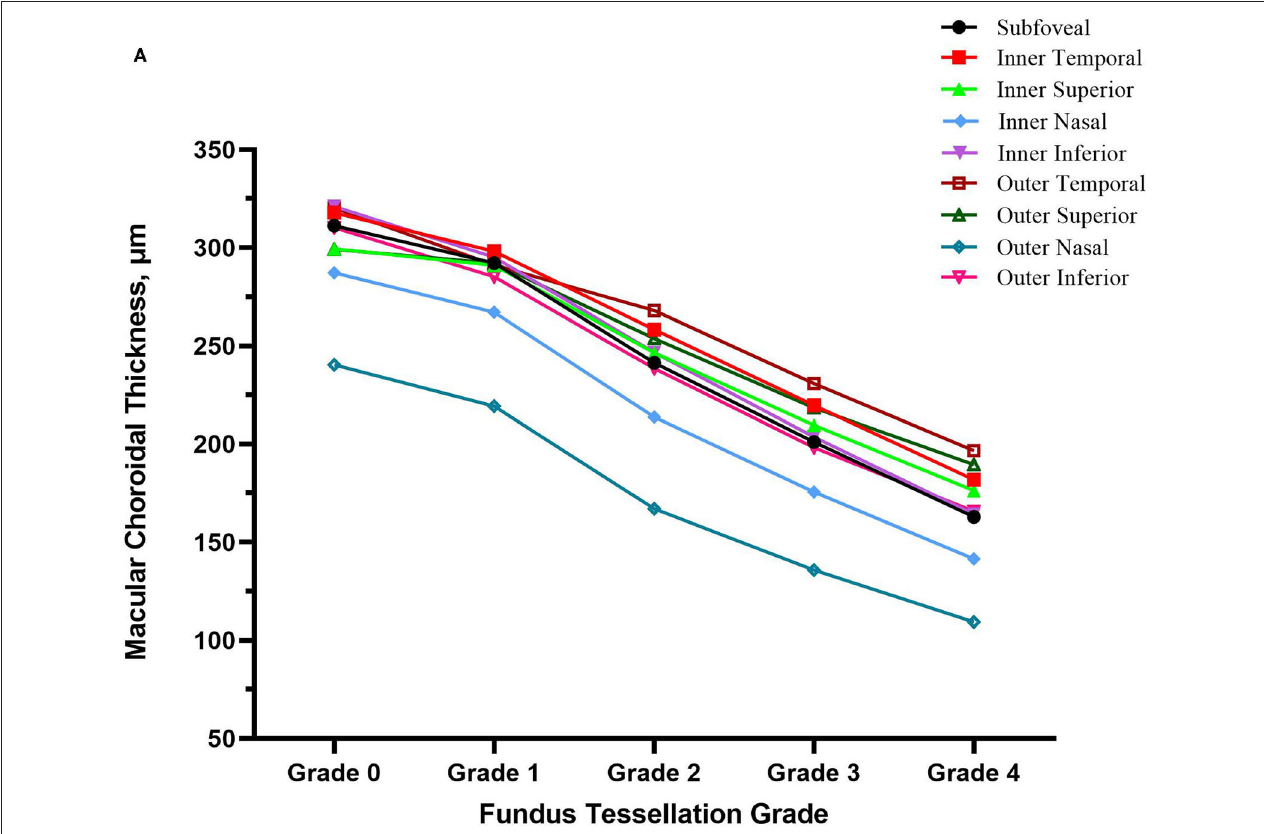
FIGURE 2 | The decrease trend of choroidal thickness in nine subregion of ETDRS grid (subfoveal, inner nasal, inner superior, inner temporal, inner inferior, outer nasal, outer superior, outer temporal, outer inferior) as fundus tessellation approaches to center